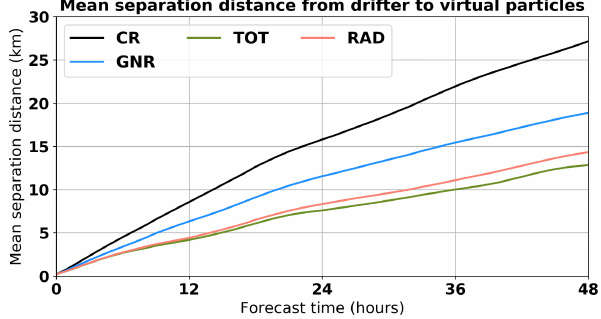
Figure 5. Mean separation distance between virtual particles and drifters as a function of the forecast horizon. Black represents the simulation without DA (i.e., control run, CR). Blue stands for generic (GNR), which assimilates data from satellite altime- try, SST and Argo profiles. Green and red lines represent the sim- ulation which assimilates HFR daily mean total (TOT) and radial (RAD) observations, respectively, together with generic observation sources. Original source: Hernández-Lasheras et al.